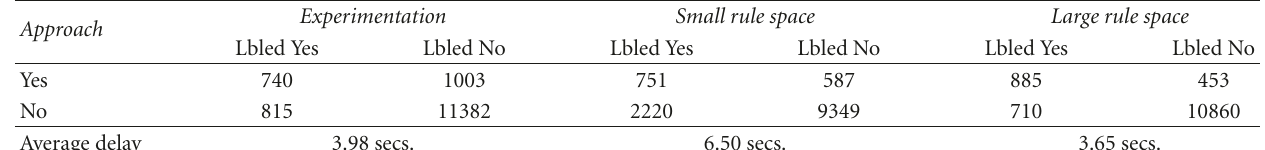
Table 3: Average confusion matrices per time interval for a dynamic stream of images.